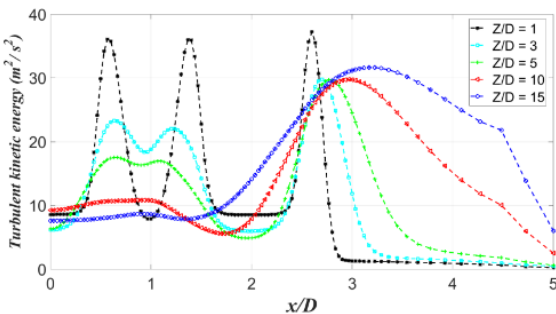
Figure 9. Turbulent kinetic energy distributions of different streamwise locations.